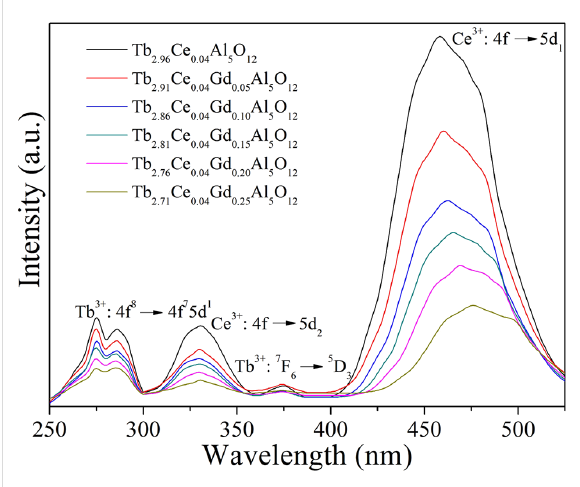
Figure 2: Excitation spectra of Tb 2.96 − x Ce 0.04 Gd x Al 5 O 12 phosphors.